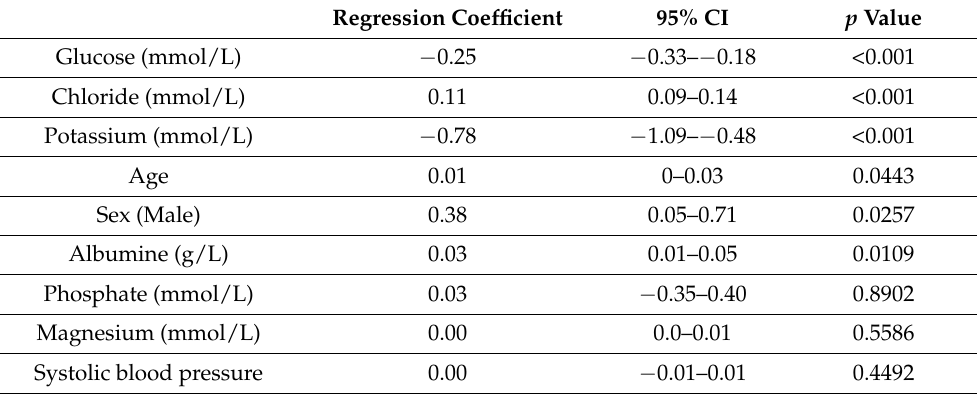
Table 2. Association of sodium with other electrolytes, blood pressure, age and